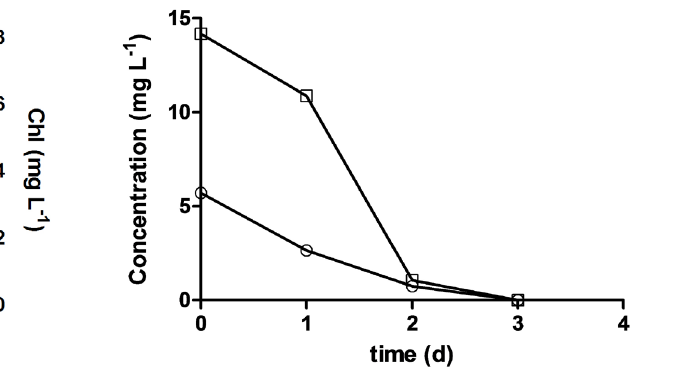
Cl concentrations 4